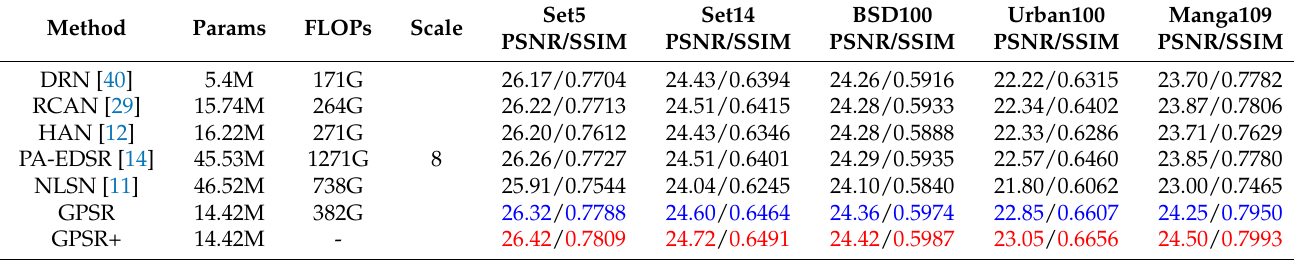
Table 5. Quantitative metrics obtained using various models for × 8 SR task with BD degradation model. The optimal and suboptimal metrics are highlighted in red and